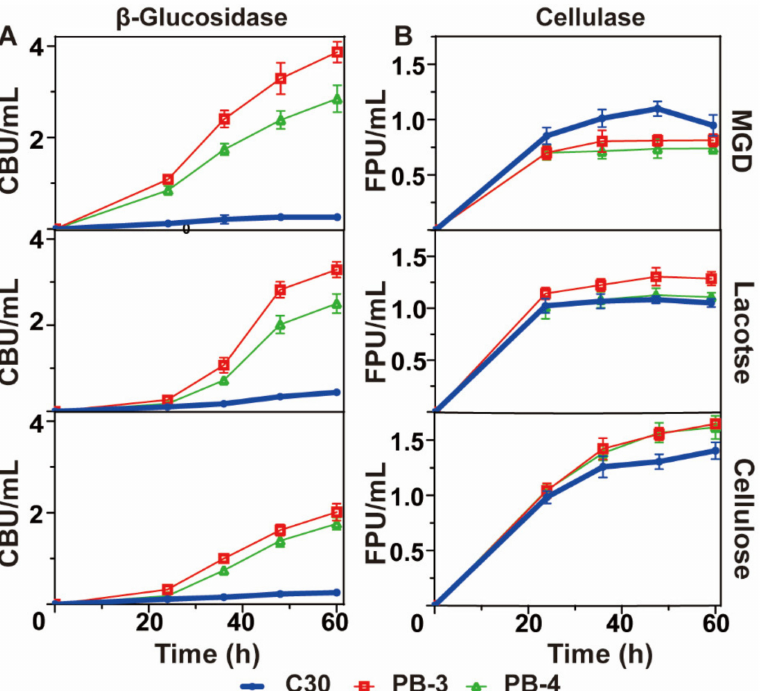
Figure 1. The cellulase and β -glucosidase production of recombinant Trichoderma reesei PB-3, PB-4 with aabgl1 overexpressed and the parent strain Rut C30. The transformants T. reesei PB-3 and PB-4 had four and three gene copies, respectively. ( A ) The β -glucosidase activities and ( B ) the cellulase activities of T. reesei Rut C30, PB-3 and PB-4 cultured with 10 g/L MGD, lactose or cellulose. For each experiment, three individual replicates were performed. The cellulase and β -glucosidase activity were expressed in filter paper units (FPU) and cellobiase units (CBU),